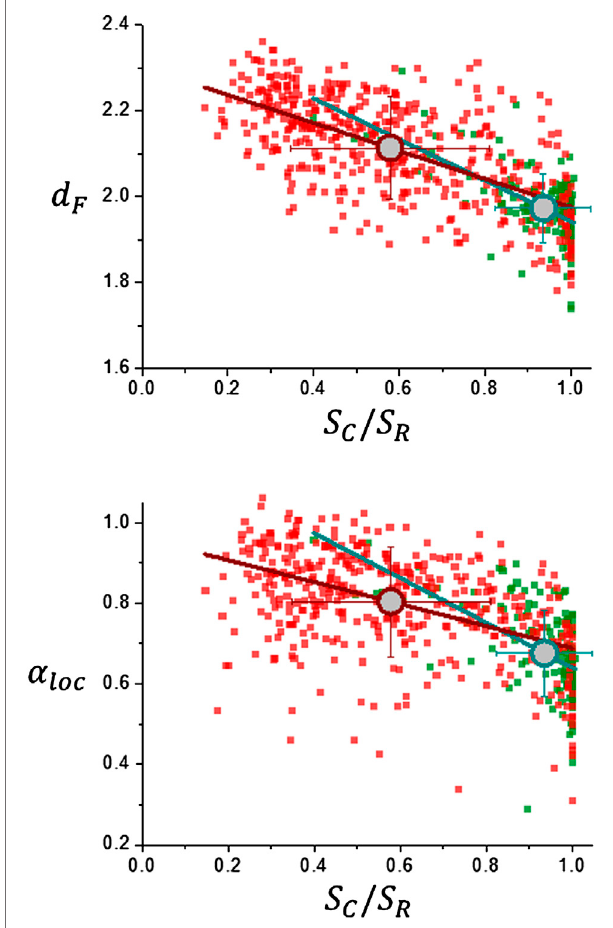
FIGURE 10 | Relationship between scaling analysis parameters d F and α loc with regularity measure ratio S C / S R . Large circles represent average values: meningiomas and acoustic schwannomas (green) and gliomas (red).